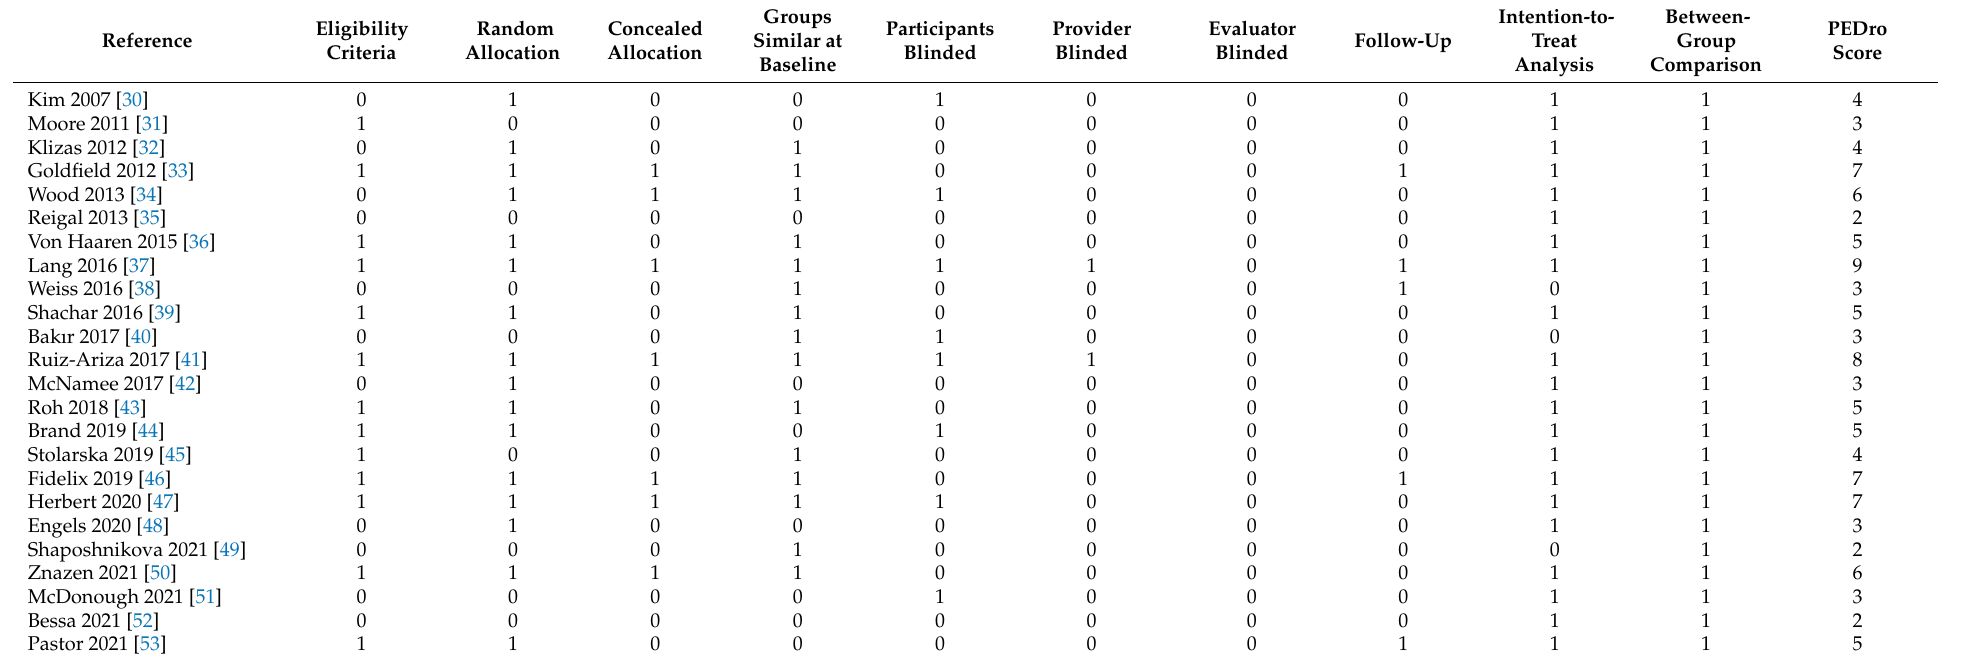
Table 2. Quality Assessment of included